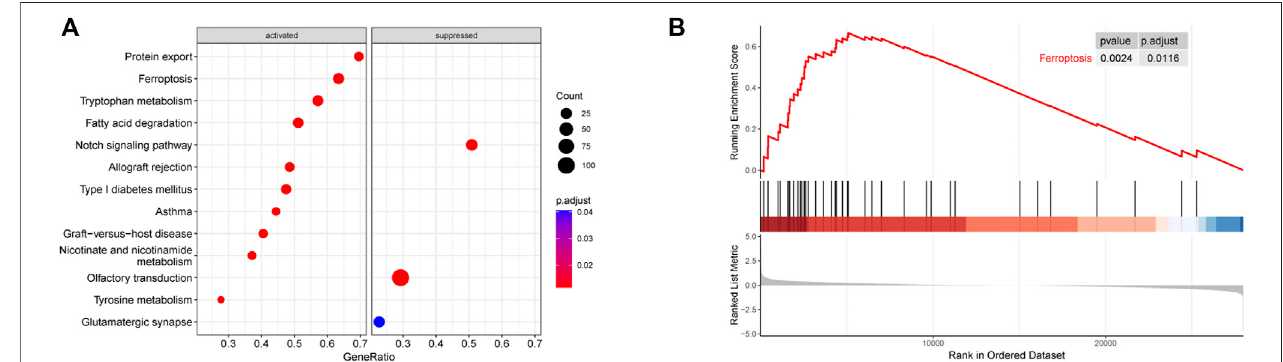
FIGURE 2 | Results of GSEA (KEGG pathways). (A) Distribution of gene ratio for the top 10 signaling pathways. (B) Enrichment plot of the ferroptosis pathway. Abbreviations: GSEA, gene set enrichment analysis; KEGG, Kyoto encyclopedia of genes and